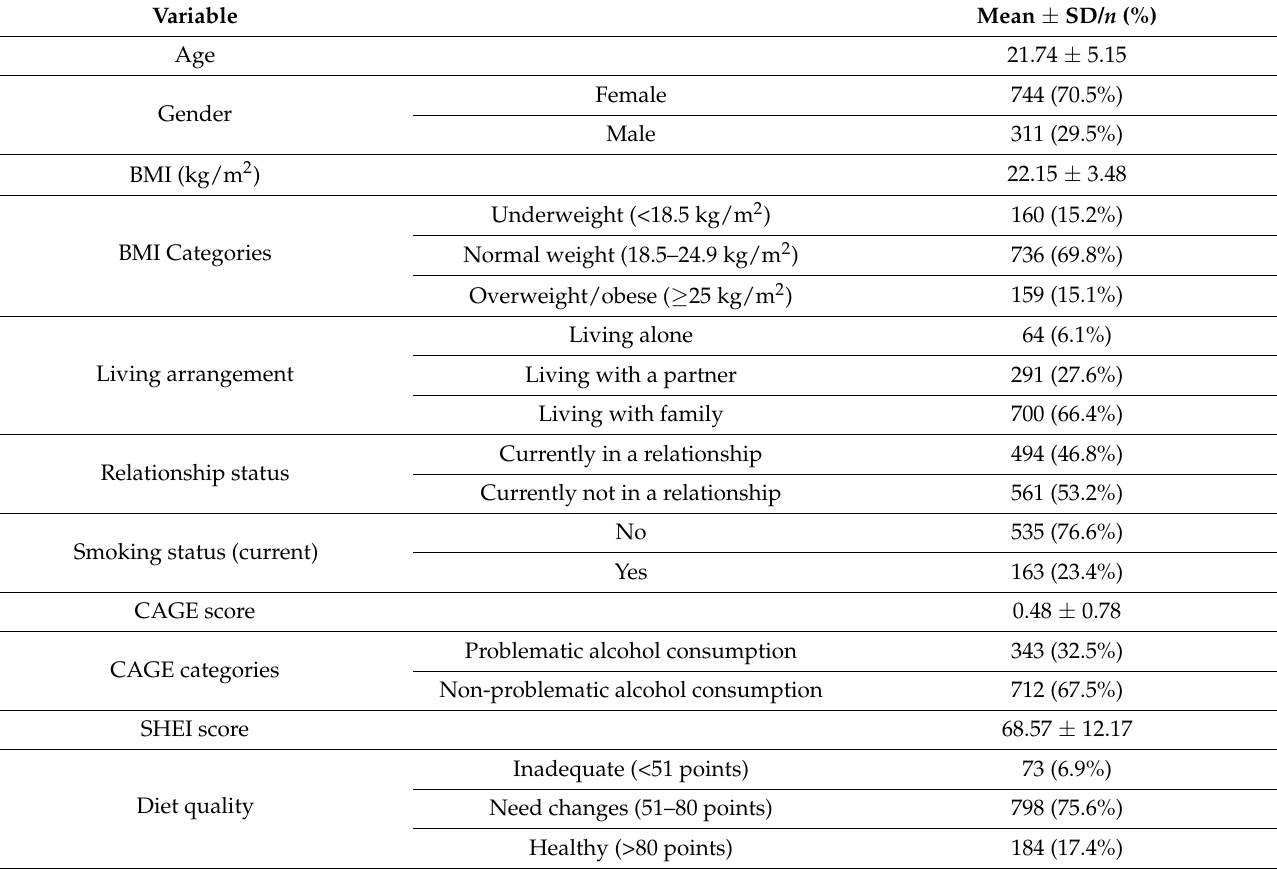
Table 3. Factors related to diet quality. Multiple linear regression model*.